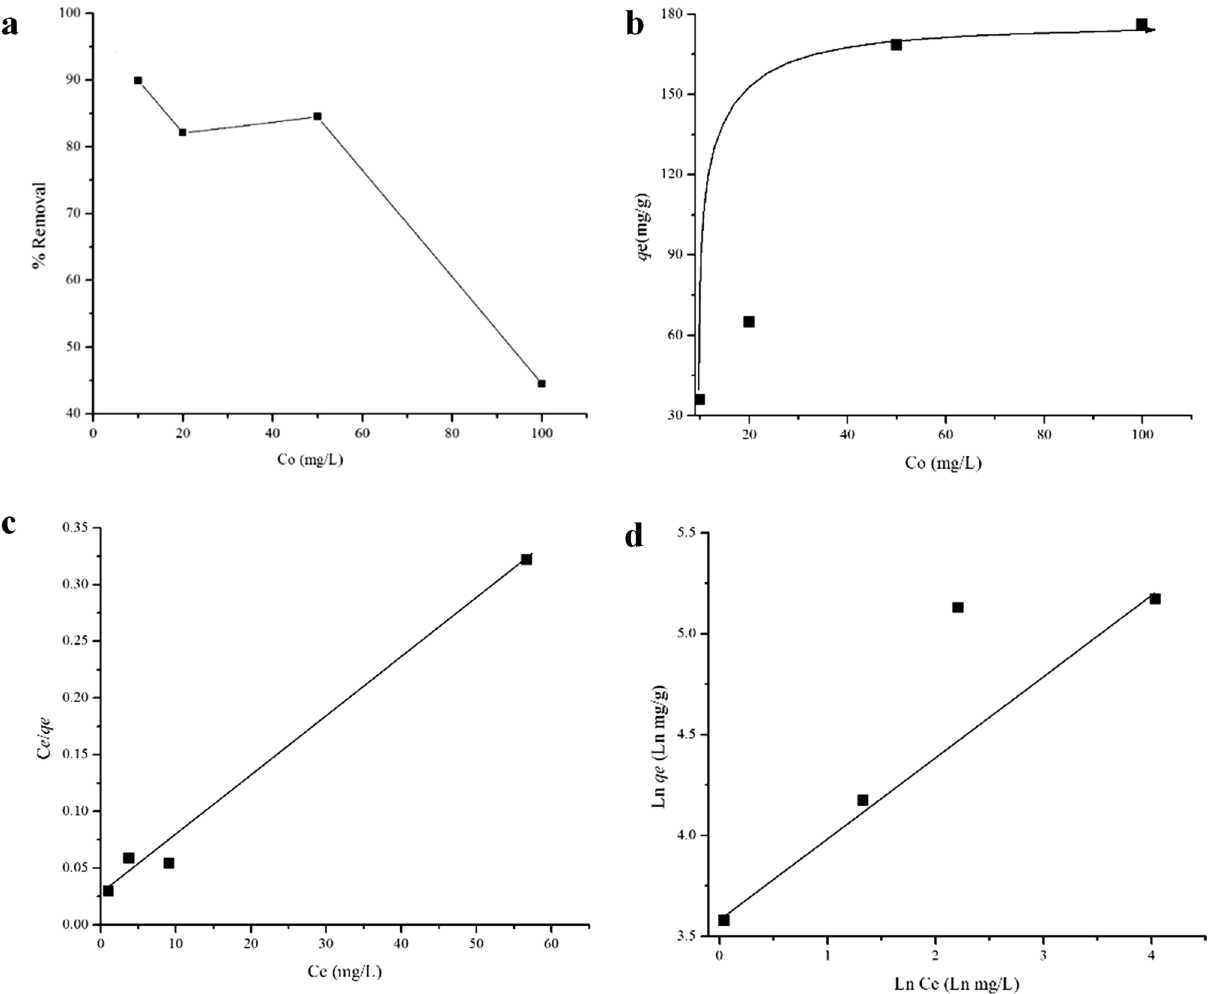
Figure 10. Initial concentration (C o ) effect ( a ), %Removal ( b ), Adsorption capacity at equilibrium (q e ) of MB fitted to isotherm of Langmuir ( c ) and Freundlich ( d ) Model.